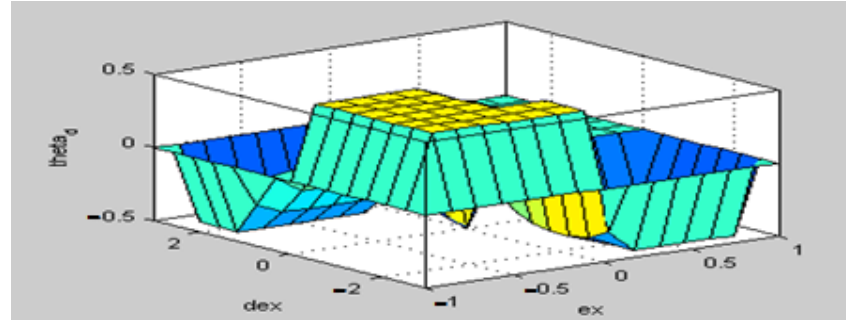
Figure 8. Surface view of FC (Z), FC (ψ).